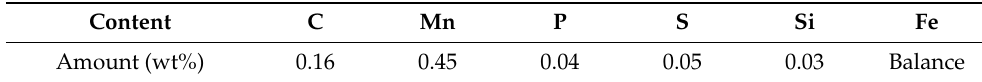
Table 1. Composition of the carbon steel